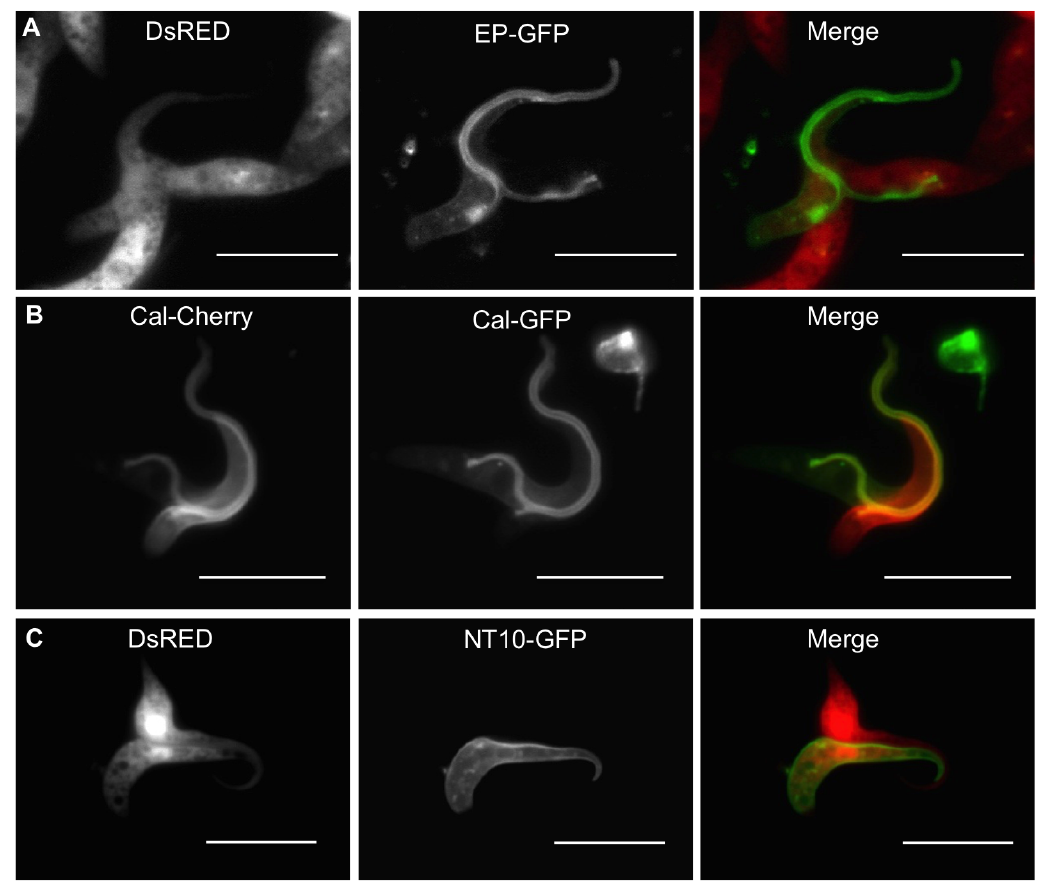
Figure 4. Exchange of different fluorescently tagged proteins indicates involvement of the flagellum. A : Interacting pair of trypanosomes expressing either DsRED ( Δ proc) or the GPI anchored surface protein EP-GFP (WT). B : Interacting pair of trypanosomes expressing the flagellar protein calflagin44-GFP (WT) or calflagin44-Cherry (WT). C : Interacting pair of trypanosomes expressing either cytoplasmic DsRED ( Δ proc) or the nucleoside transporter NT10-GFP (WT), which localises to the surface of the cell body, but not to the flagellum. The scale bar indicates